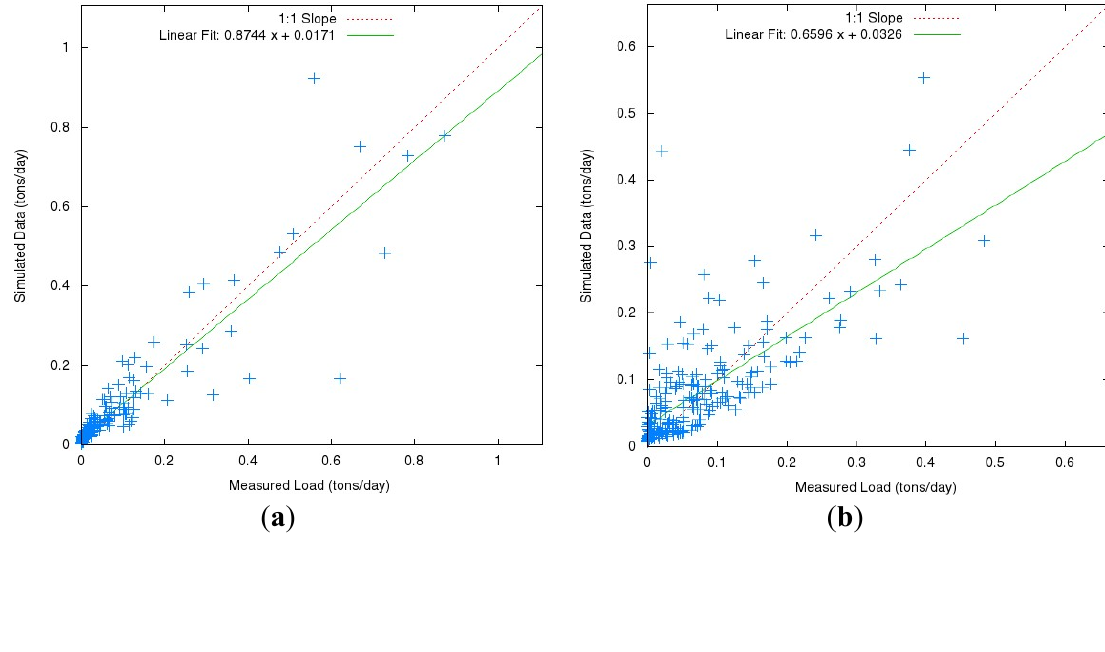
Figure 4 . Scatter plots of measured and estimated nitrogen loads; ( a ) USGS station number 03353637; ( b ) USGS station number 05427948; ( c ) USGS station number 04063700; ( d ) USGS station number 04087000; ( e ) USGS station number 04059000; ( f ) USGS station number 04137500; ( g ) USGS station number 04101500; ( h ) USGS station